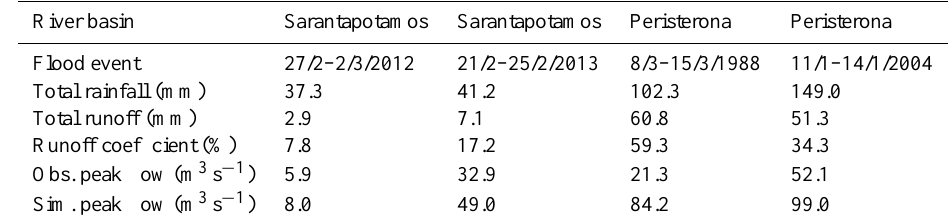
Table 3. Summary information for the examined flood events at Sarantapotamos and Peristerona basins. River